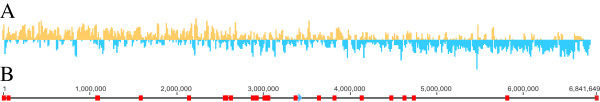
Features of linear S. albus J1074 chromosome. (A) GC-skew pattern of S. albus J1074 chromosome showing overrepresentation of C over G (yellow) and G over C (blue) in the strand analysed; (B) Distribution of mobile elements though the S. albus chromosome. The origin of replication is marked with a blue triangle.